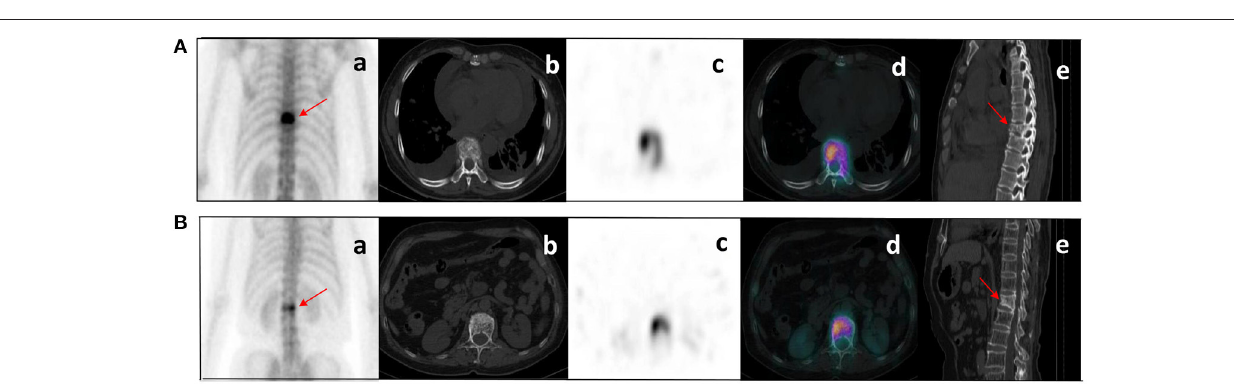
and cannot quantify the spatial heterogeneity of the overall metabolic